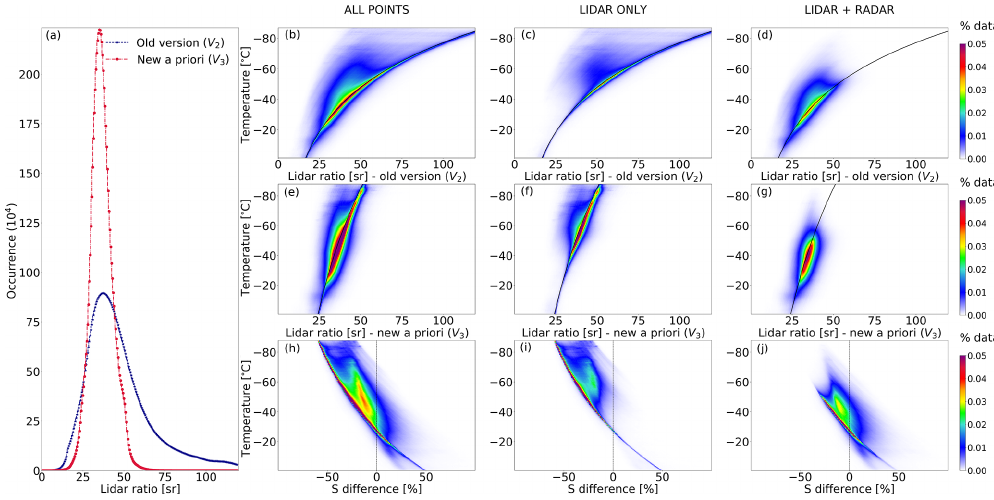
Figure 6. Comparison of the retrieved lidar ratios for two a priori parameterizations: histograms of S (a) with the old a priori relationship (dashed) and the new relationship (solid), probability density distributions of S as a function of temperature obtained when using the old configuration (b–d) and the same results with the new configuration (e–g) , probability density distribution of the relative difference between the two lidar ratios obtained from the two different configurations at each retrieved pixel (h–j) . The black line represents the a priori